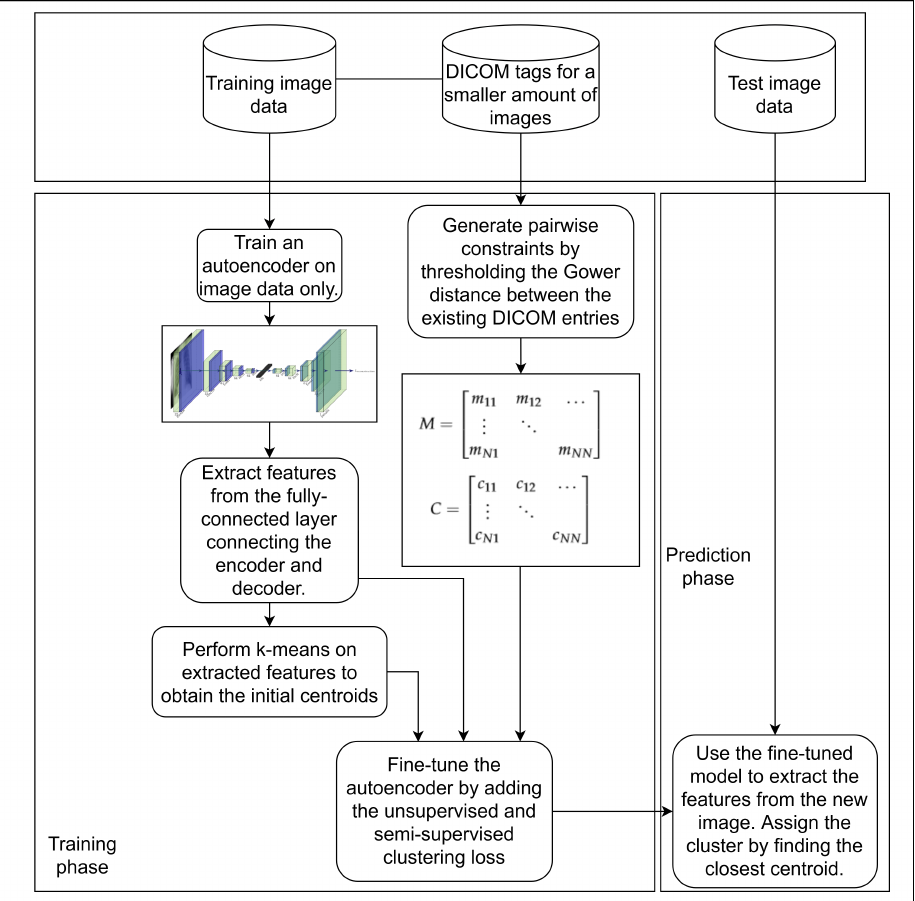
Figure 1. A flowchart showing the steps in the algorithm training and prediction